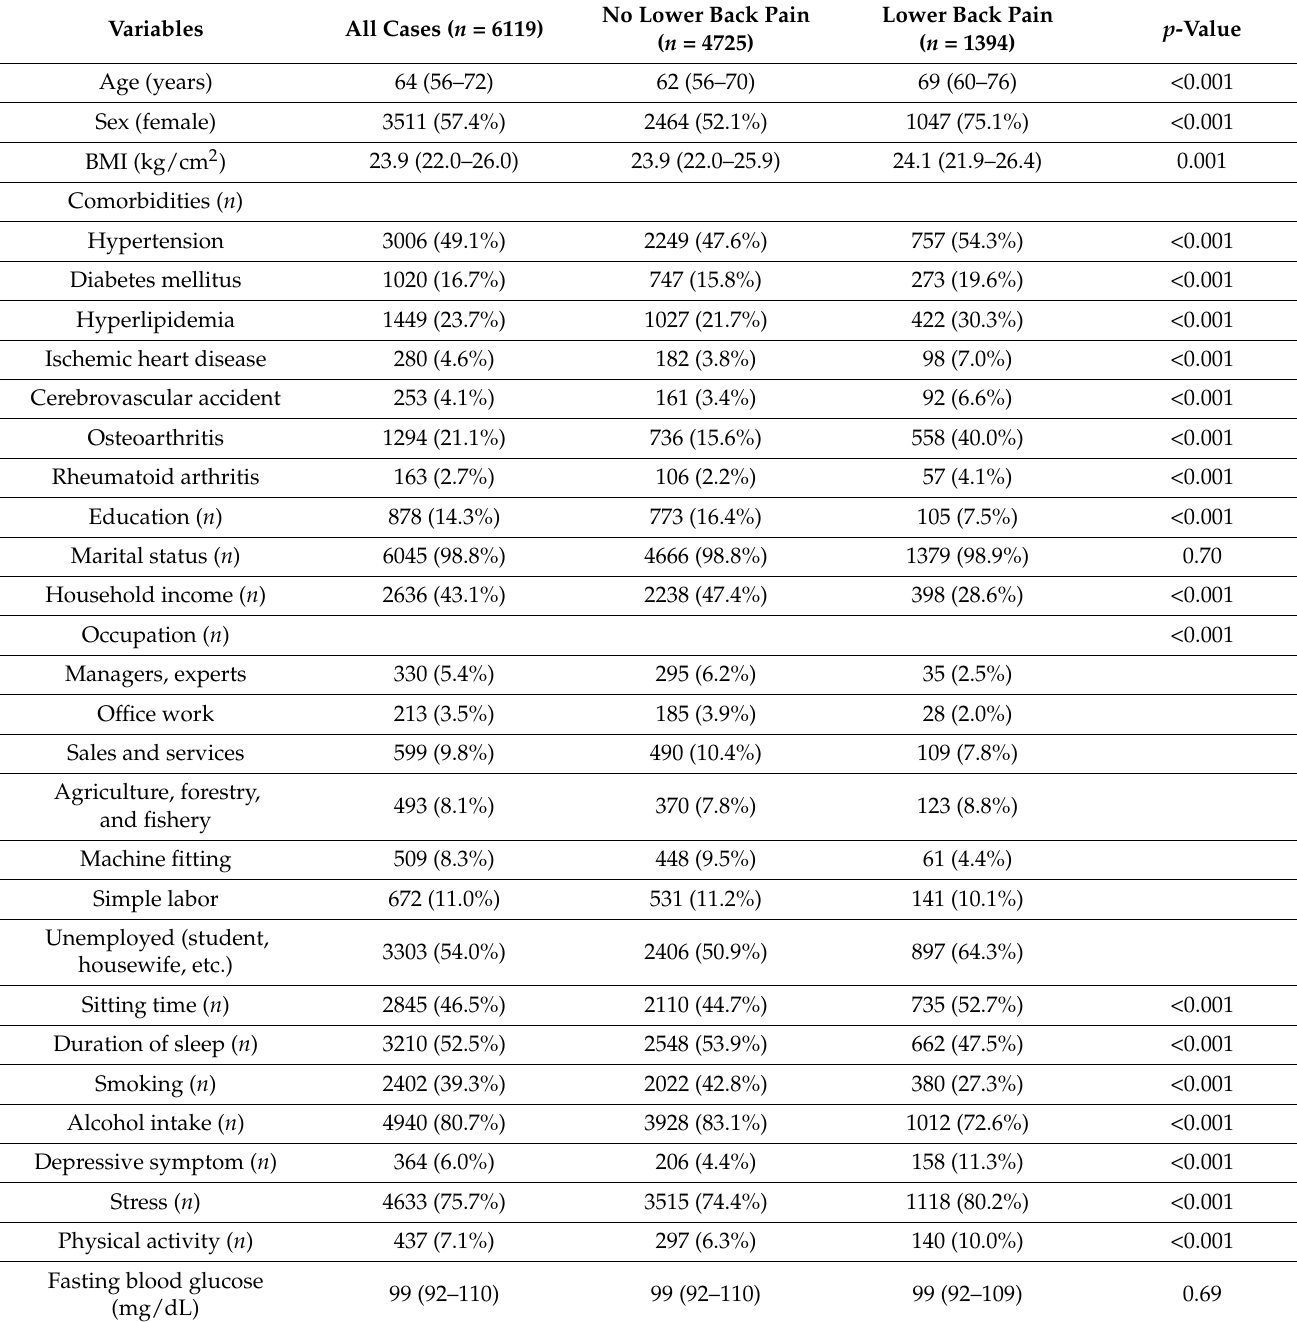
Table 1. Demographic data and variable features of the included